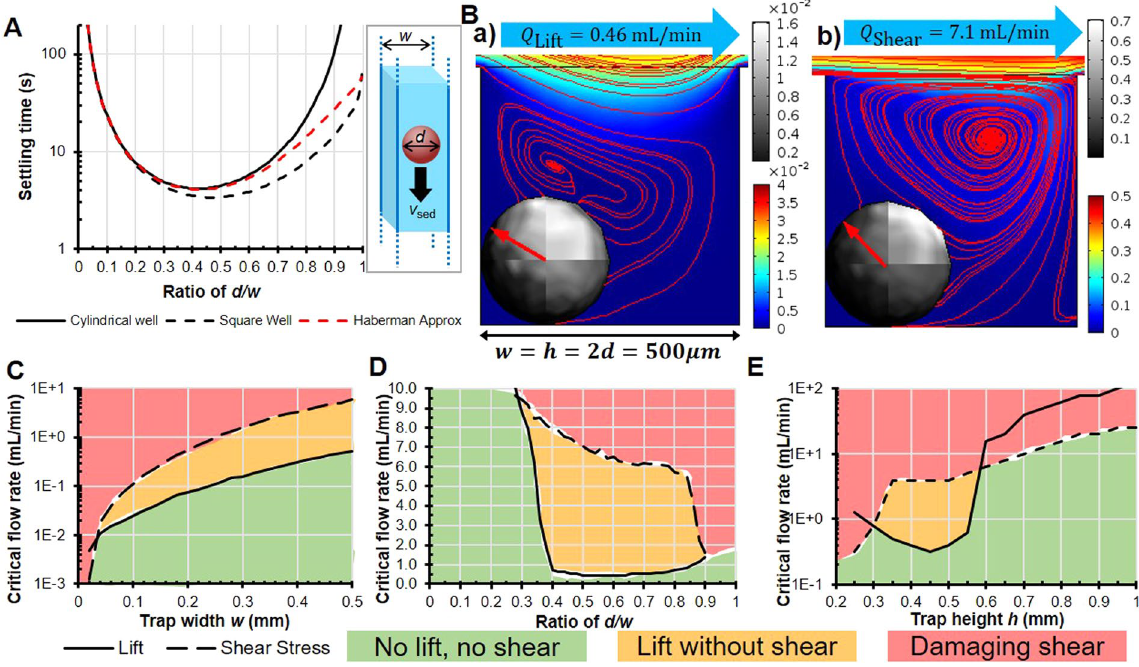
Figure 3. Hydrodynamic numerical results ( A ) Settling time as a function of the ratio of tissue diameter d over trap width w (as pictured in the inset) for two well cross-sections (cylindrical and square) compared to the analytical approximation by Haberman et al . 32 . Settling distance over a height of w (cubic well) for tissues 2% heavier than water. ( B ) Streamlines (red lines), flow velocity colour map (mm/s) in the well around the tissue, and shear stress greyscale map (Pa) on the tissue with the net resulting force of the flow on the tissue (red arrow) for a flow rate generating tissue lift Q lift (a) and generating damaging shear stresses Q shear (b). Phase diagram representation of critical flow rates for tissue ejection Q lift and tissue shearing Q shear for ( C ) varying trap width (or device scale) with a constant ratio d / w = 0.5 and w = h (result of ~5,800 simulations), ( D ) varying diameter over trap width ratios with w = h = 0.5 mm (result of ~4,300 simulations) and ( E ) varying trap height with a